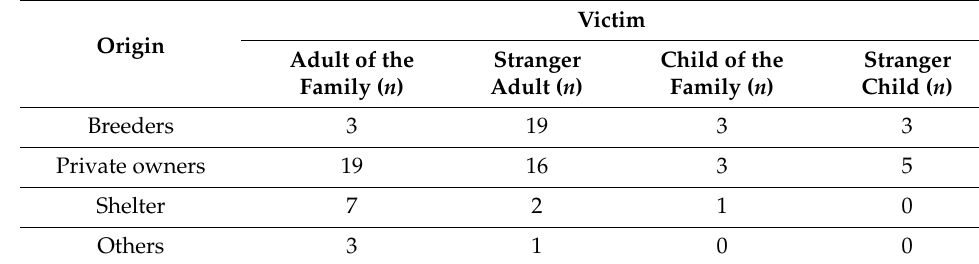
Table 16. Comparisons between the type of victim and dog